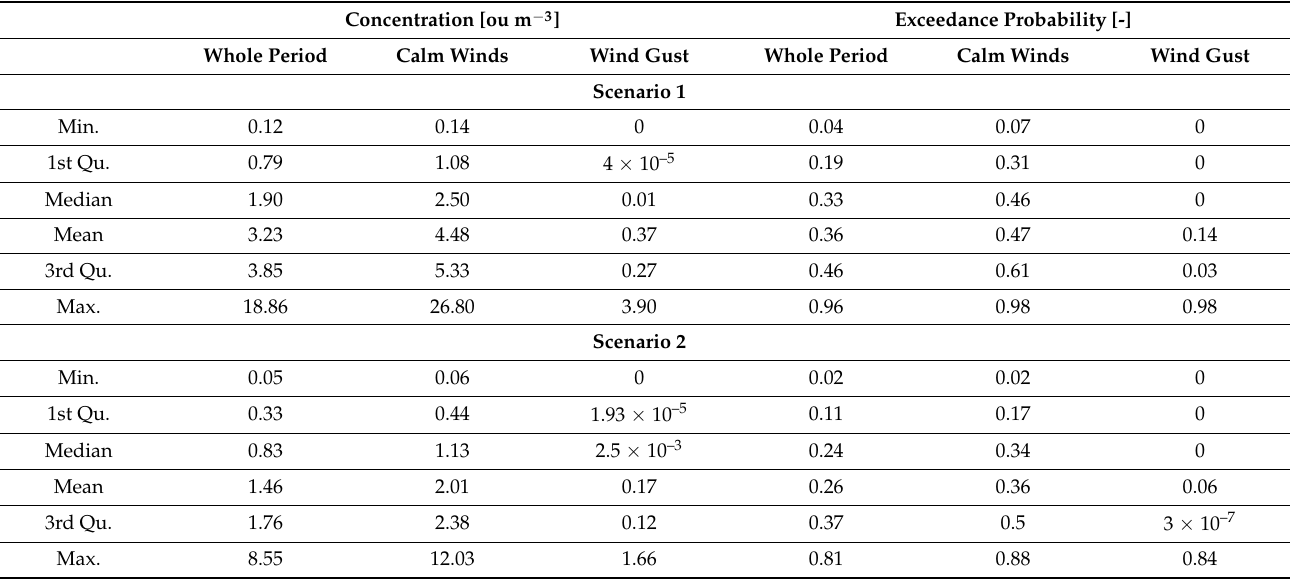
Table 4. Odour concentration and exceedance probability statistics for scenarios 1 and 2: minimum, median, mean, 1st and 3d quartiles, maximum. The statistics are provided for the whole period, for the wind calm conditions, and for the wind gust episode.